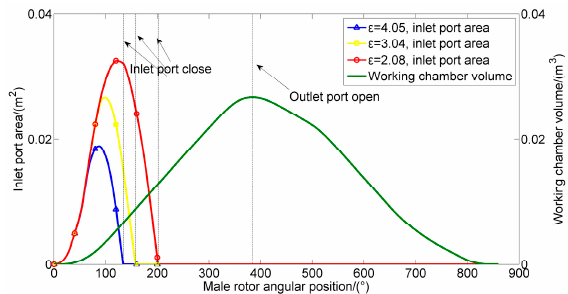
Figure 4. Inlet area and volume curve of the screw expander.